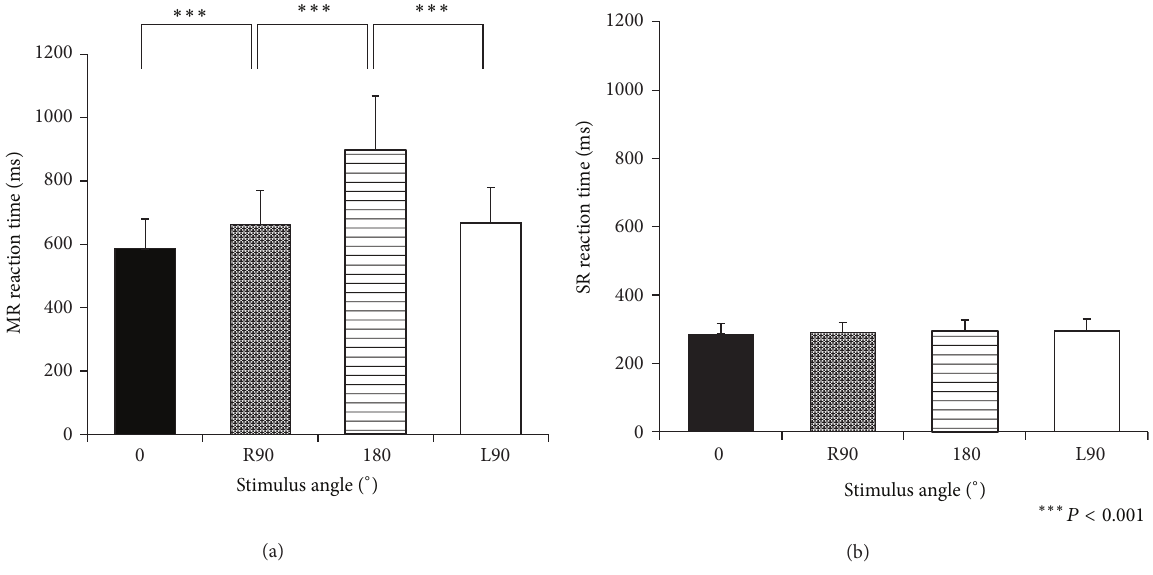
Figure 4: Mean reaction times for (a) MR of foot stimulus angle and (b) SR of foot stimulus angle in Experiment 2. Error bars depict the standard deviation of the mean. Table 2: Comparison of pre- and postintervention in each sway value for two standings in the three kinds of interventions in Experiment 2. Unipedal standing Bipedal standing Pre Post Pre